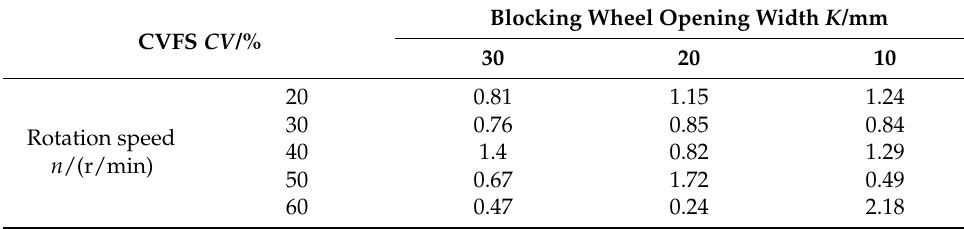
Table 7. Results of coefficient of variation of fertilization stability (CVFS) determination tests.